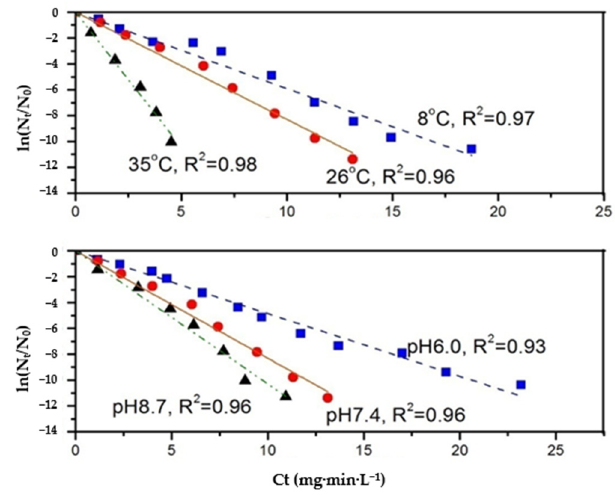
Figure 4. Inactivation on N. europaea applying chlorine dioxide. Experiments were conducted in PBS buffers at temperature varying from 8 °C, 26 °C to 35 °C, and pH varying from 6.0 to 8.7. Linear regressions based on the Chick–Watson model was represented as Equation (1) for different pH and temperature conditions. R 2 represents correlation coefficient values.